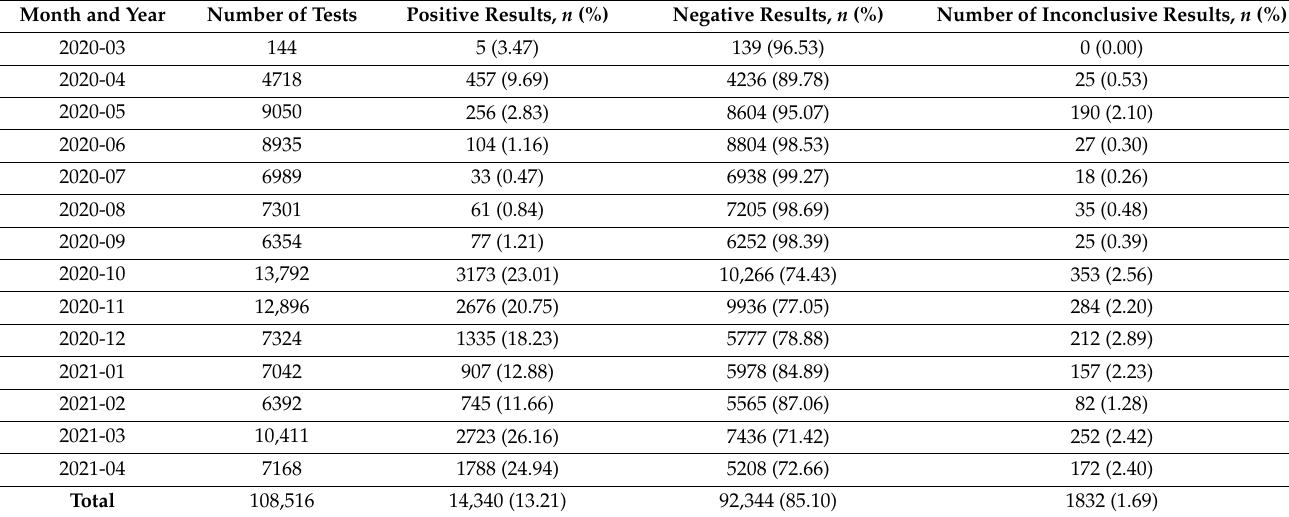
Table 1. Number of tests per month and type of